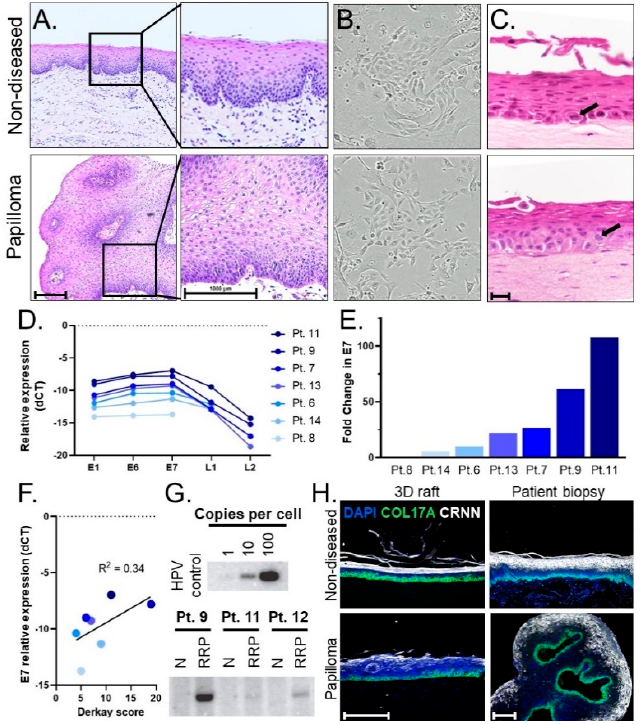
Figure 1. ( A ) Histology of pediatric laryngeal papilloma and non-diseased tissue biopsy (H&E stain). Scale bar, 1000 μ m. ( B ) 10× images of papilloma and non-diseased primary keratinocyte cells cultured from matched patient biopsies exhibiting healthy growth and normal morphology. ( C ) Representative images of 3D organotypic rafts generated from matched primary cells. An ectopic mitotic figure (arrow) is shown in a raft generated from papilloma derived cells as compared to the normal location of the mitotic figure (arrow) in the basal layer of the raft generated from non-diseased tissue-derived cells. Scale bar, 20 μ m. ( D ) Relative expression (-dCT values normalized to β -actin) of HPV viral genes using matched primary cells from 7 patients, with L1 and/or L2 levels in 3 patients below the limit of detection. Higher values (smaller negative numbers) corresponded to higher viral gene expression. ( E ) Fold change of E7 gene expression is expressed relative to patient 8, who harbors the lowest E7 expression levels. ( F ) Scatterplot showing positive correlation (r-squared 0.34) between the level of E7 gene expression and Derkay scores as a measure of disease severity. ( G ) Southern blots for HPV6 genome detection showing genome copies in papilloma (RRP), but not non-diseased (N), primary cells with high patient variability in viral load. ( H ) Epithelial layers present in the stratified epithelium of patient biopsies are modeled in derivative 3D organotypic rafts. Basal layer, COL17A (green); differentiated layer, CRNN (white); cell nuclei, DAPI (blue). Scale bar, 100 μ m.